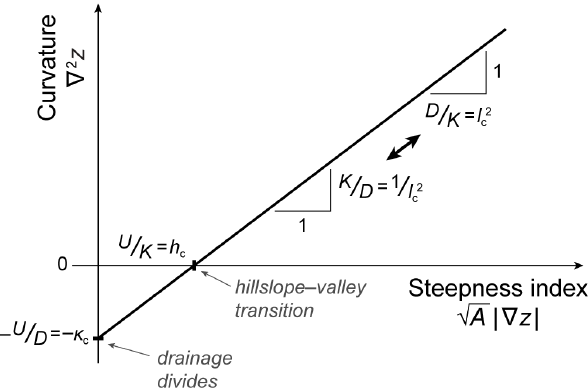
Figure 1. Relationship between curvature and the steepness index in steady-state topography without an incision threshold. We plot a straight line defined by Eq. (10) or (11), which describes how curva- ture should be related to the steepness index if the landscape follows the LEM (Eq. 1) and is in steady state. This line is parameterized by the characteristic scales of length and height ( l c and h c ; Eqs. 3 √ A |∇ z | = h c , an 4); its slope is 1 /l 2 c , its horizontal-axis intercept is and its vertical-axis intercept is ∇ 2 z = − κ c (where κ c is a char- acteristic curvature defined as h c /l 2 c ; Eq. 8). These intercepts re- veal topographic properties of special points in a landscape, namely the steady-state curvature of drainage divides and the steady-state steepness index of hillslope–valley transitions. The characteristic length l c quantifies the competition between knickpoint advection and diffusion and predicts how landscape dissection scales with the parameters. Thus, the slope of the curvature–steepness index line visually expresses how dissected a landscape is. Note that the line’s slope can be represented either as K/D = 1 /l 2 c units of curvature per 1 unit of steepness index or 1 unit of curvature per D/K = l 2 c units of steepness index. For simplicity, we use the latter notation to express the slopes of the lines in Figs.